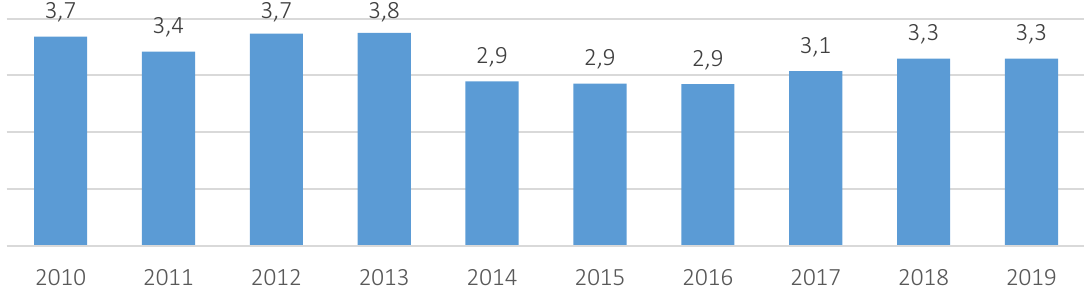
Figure 7. Domestic general government health expenditure (% of GDP), Ukraine,